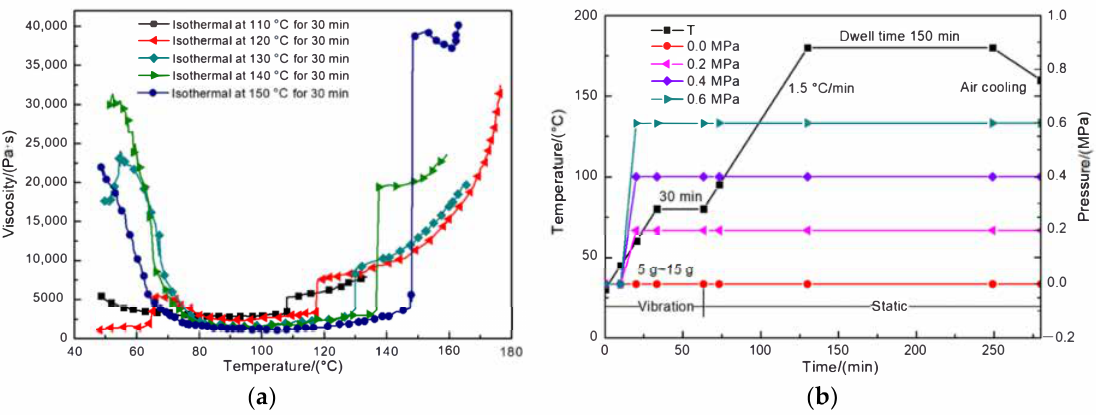
Figure 2. ( a ) Viscosity curves with different curing processing highlighted in Ref [31], ( b ) curing cycles for RVAVP and autoclave